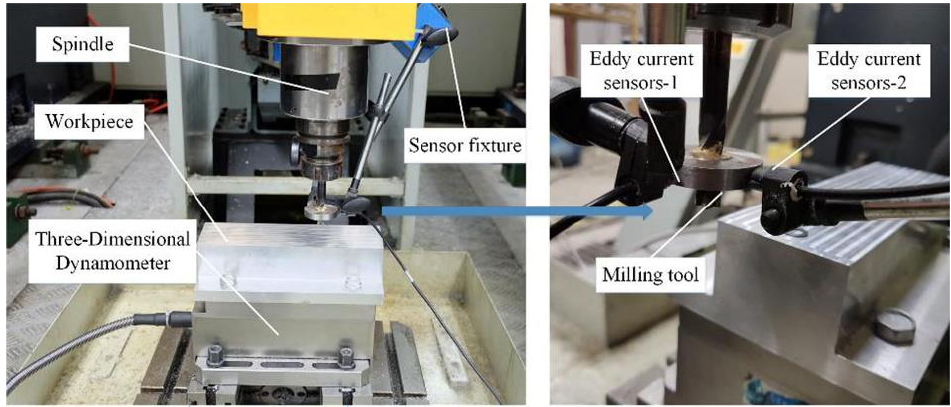
Figure 5. Photographs of the experimental setup for making on-line measurements of milling cutter